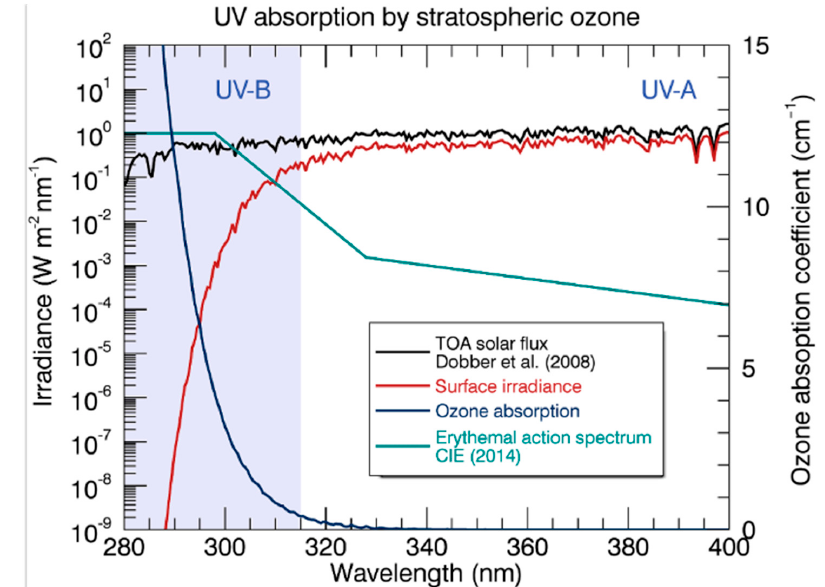
Figure 1. Sample surface UV irradiance spectrum on a clear summer day. Stratospheric ozone (Huggins–Hartley band system—blue curve) absorbs the radiative flux (black curve) in the UV-B region) resulting in the net surface irradiance (red curve). Susceptibility of human skin to epidermal damage is demonstrated by the erythemal action spectrum (green curve) [18]. © Crown copyright